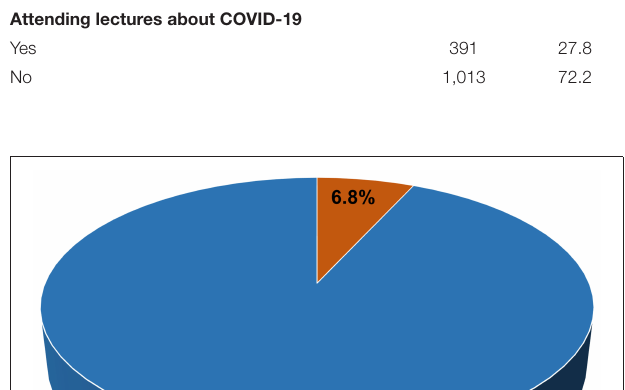
TABLE 3 | The differences of self-reported, COVID-19 preventive measures related obsession by the socio-demographic characteristics of medical students. Socio-demographic and clinical variable